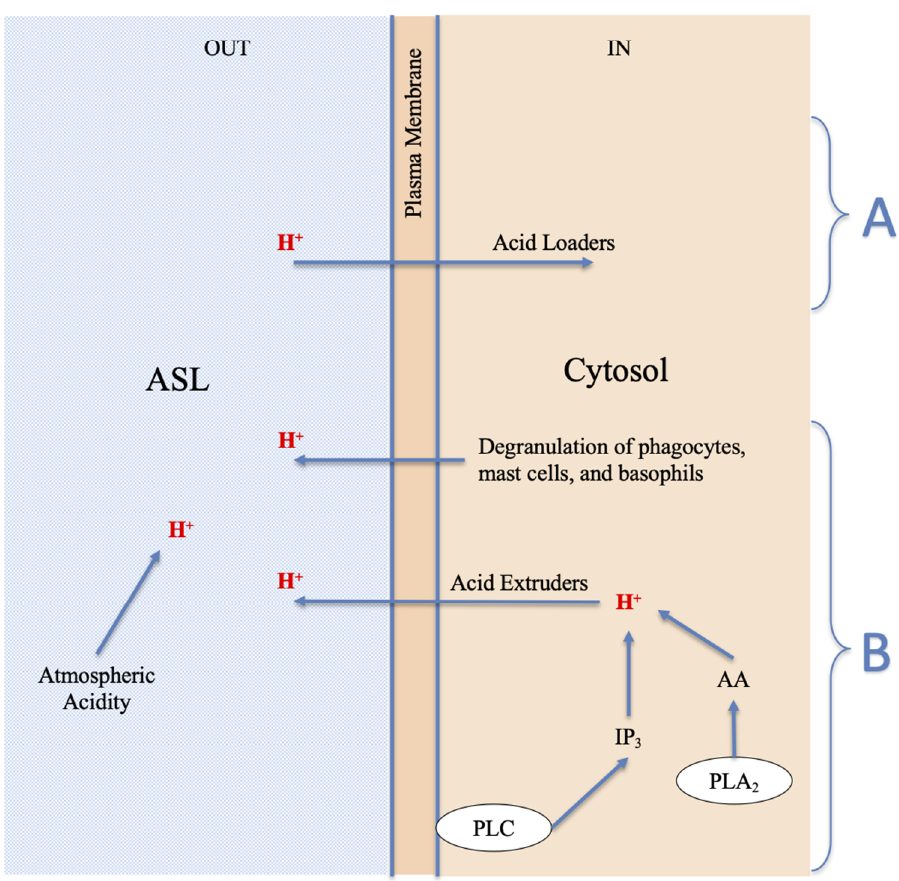
Figure 2. Biochemical routes for variation in pH of the Airway Surface Liquid (ASL) . A) Acid loaders: Cl - /HCO 3- exchanger; Na + - HCO 3- cotransporter; PMCA pump; TRP, ORAI and ASIC Cl − / HCO 3 − exchanger; Na + - HCO 3 − cotransporter; PMCA pump; TRP, ORAI and ASIC channels; channels; CO 2 /Carbonic Anhydrase system, etc. B) Acid extruders: NHE exchanger; Hv1, TRP, and CO 2 / Carbonic Anhydrase system, etc. ( B ) Acid extruders: NHE exchanger; Hv1, TRP, and CFTR channels; ATPase pumps, etc. PLA 2 —Phospholipase A 2 ; PLC—Phospholipase C; IP3—Inositol 1,4,5-trisphosphate; AA—Arachidonic Acid.